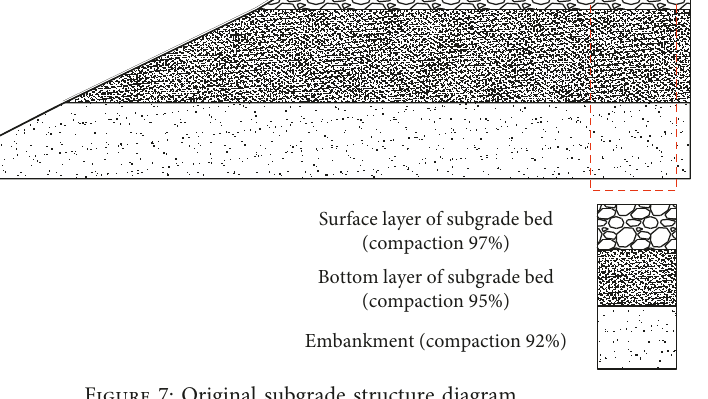
Figure 7: Original subgrade structure diagram.